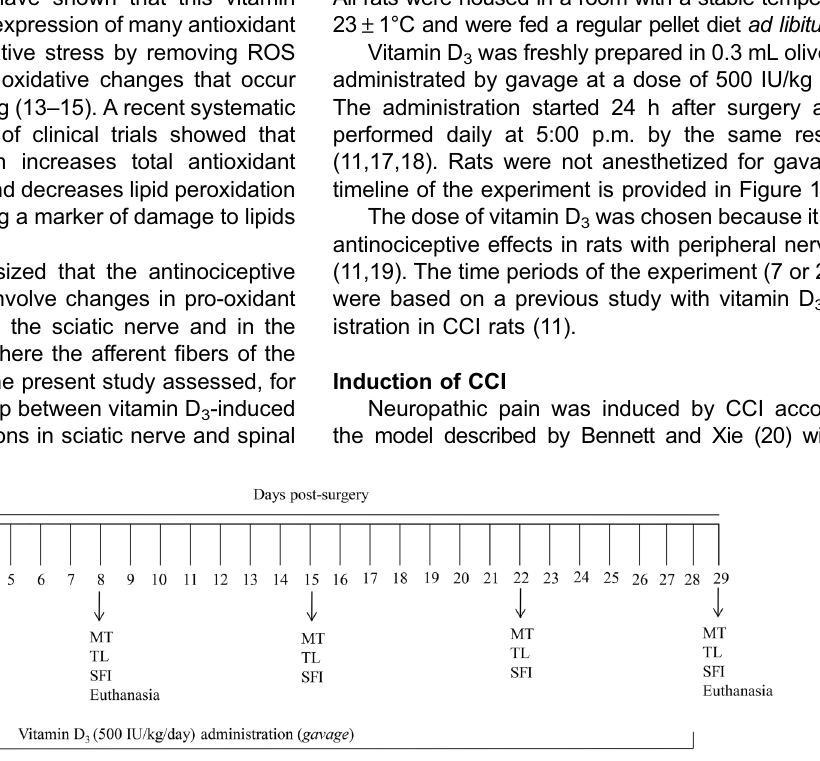
Braz J Med Biol Res | doi: